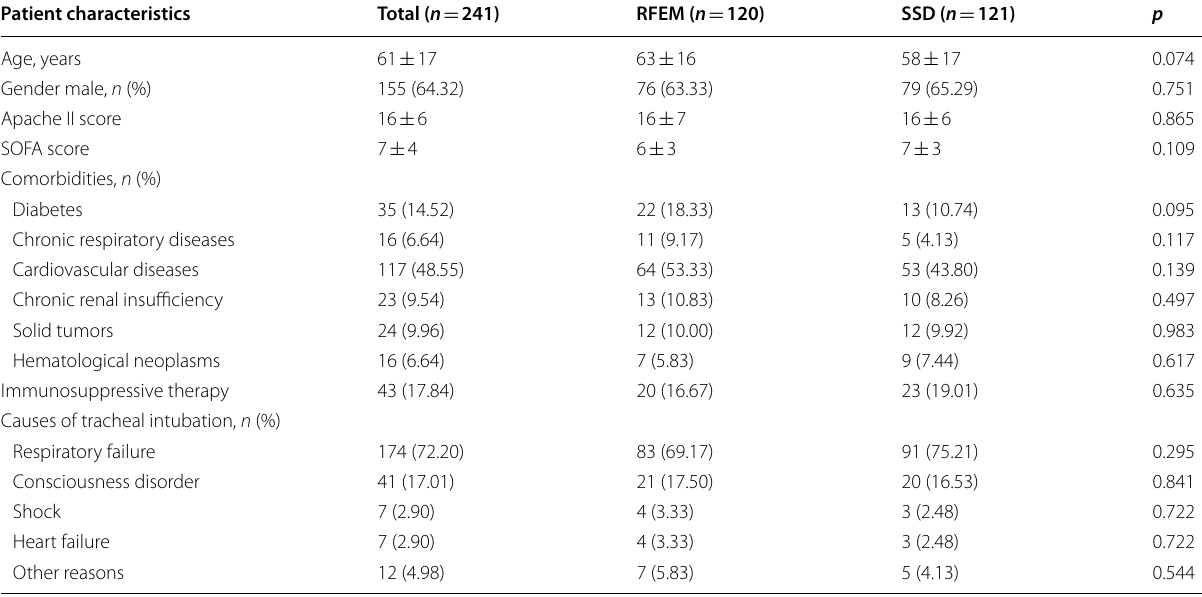
APACHE Acute Physiology and Chronic Health Evaluation, SOFA Sequential Organ Failure